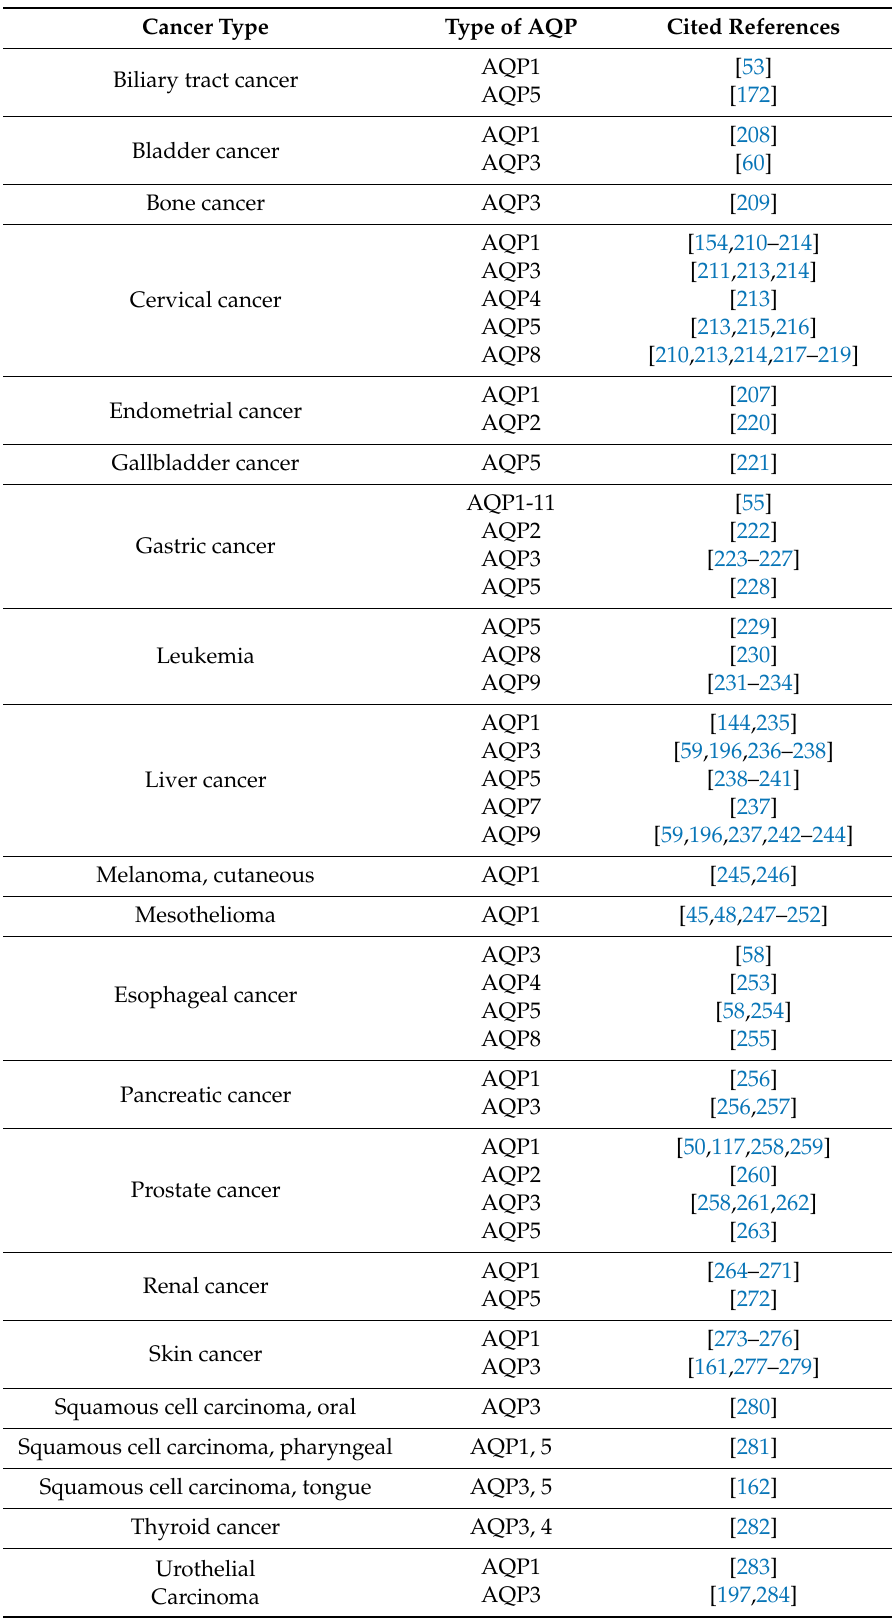
Table 7. Publications on AQPs in other cancer